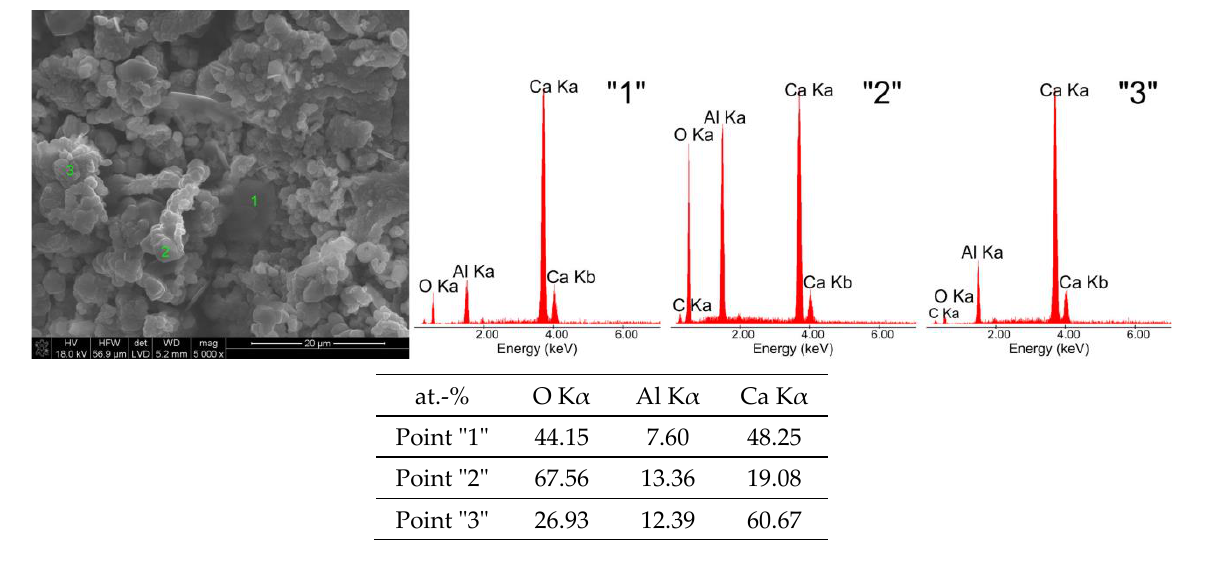
Figure 3. SEM microphotographs of tricalcium aluminate after exposure in water (W) and EDS quantitative point analyses of areas 1, 2, 3.